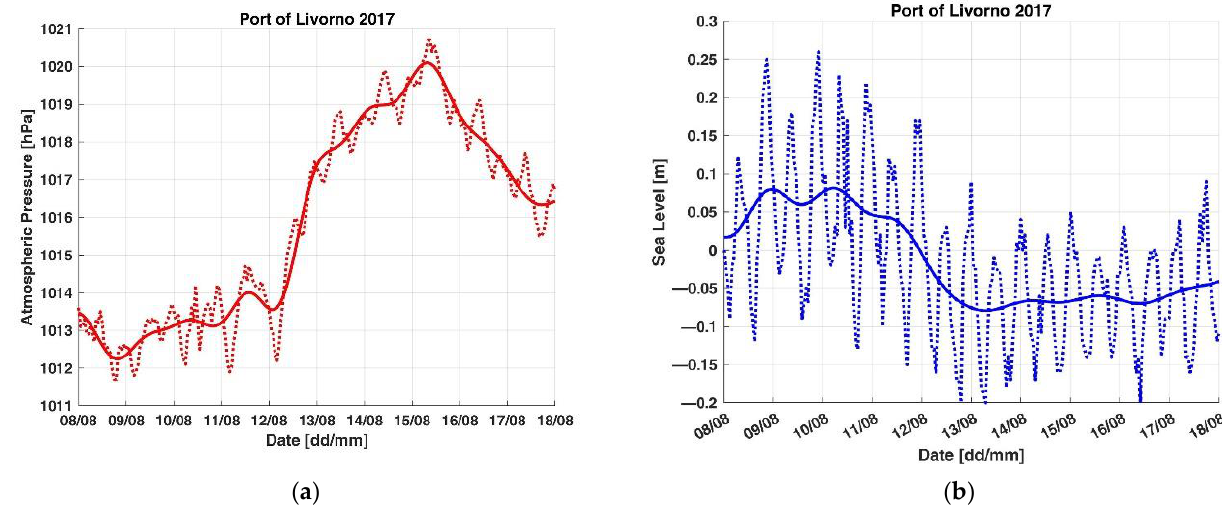
Figure A7. Low-frequency components of meteo-mareographic parameters acquired by ISPRA’s monitoring station in the port of Livorno from 8 to 18 August 2017: ( a ) atmospheric pressure; ( b ) sea level.